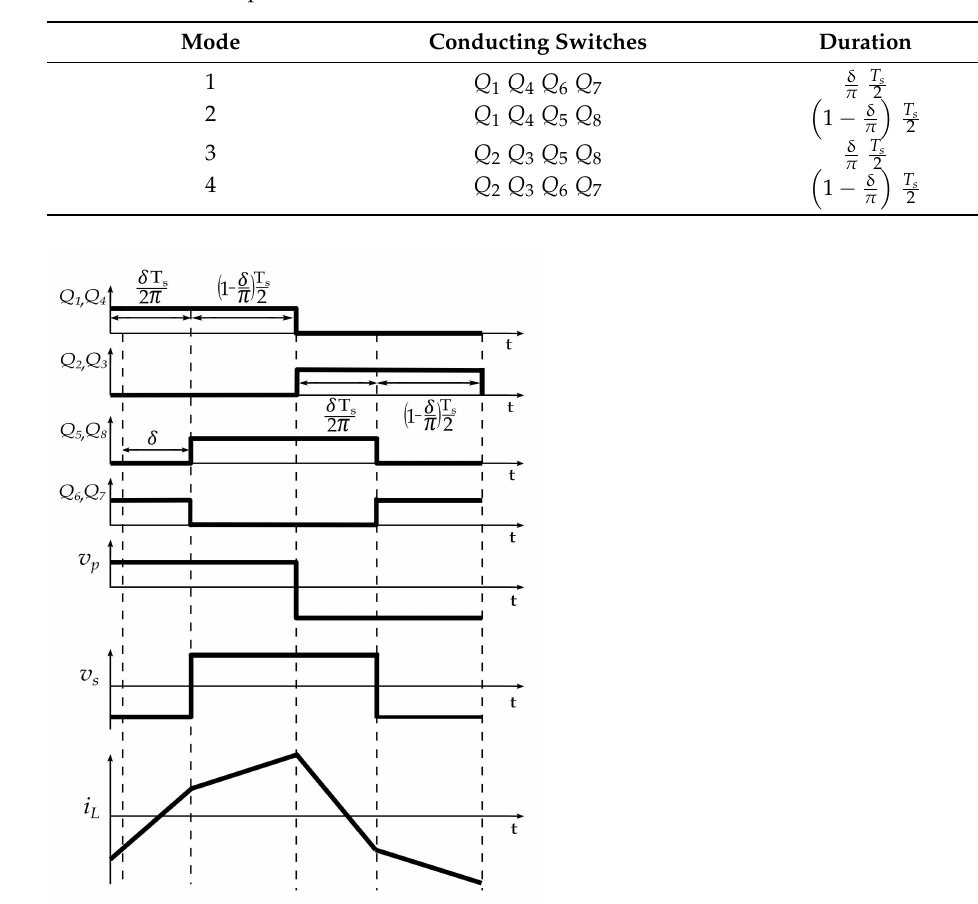
Table 1. SPS-DAB Operation Modes.